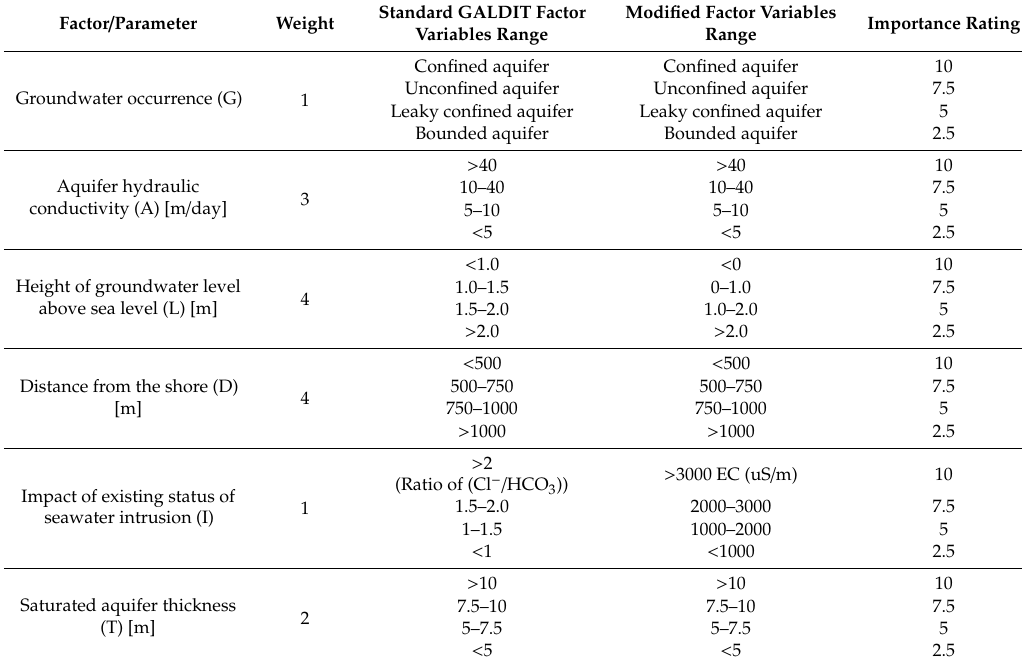
Table 1. Assessment guidelines for GALDIT